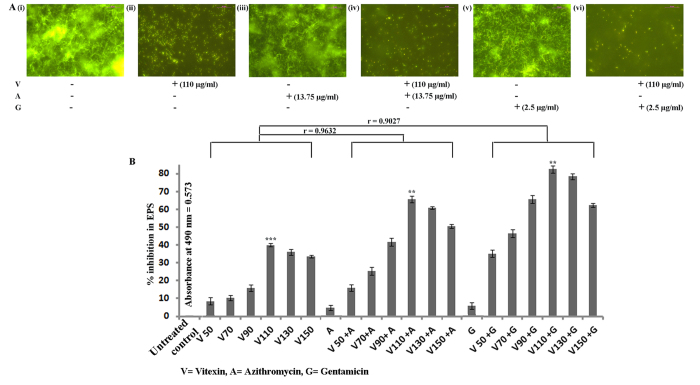
Synergistic antibiofilm effect of azithromycin and gentamicin separately on vitexin upon P. aeruginosa.After treatment biofilm were stained with acridine orange and observed under fluorescence microscope. Maximum effect of treatment with respect to untreated control are shown here (A). Each experiment was performed using three independent cultures; one representative data set is shown here. EPS quantity of Pseudomonas aeruginosa biofilm after treatment with vitexin alone, combination of vitexin-azithromycin and vitexin-gentamicin were estimated UV-vis spectrophotometrically and expressed as percentage inhibition (with respect to untreated control) (B). Each value is the average of triplicate assay where presented data is mean ± SD. Correlation study between experimental sets was done through Pearson’s correlation and expressed by r value.